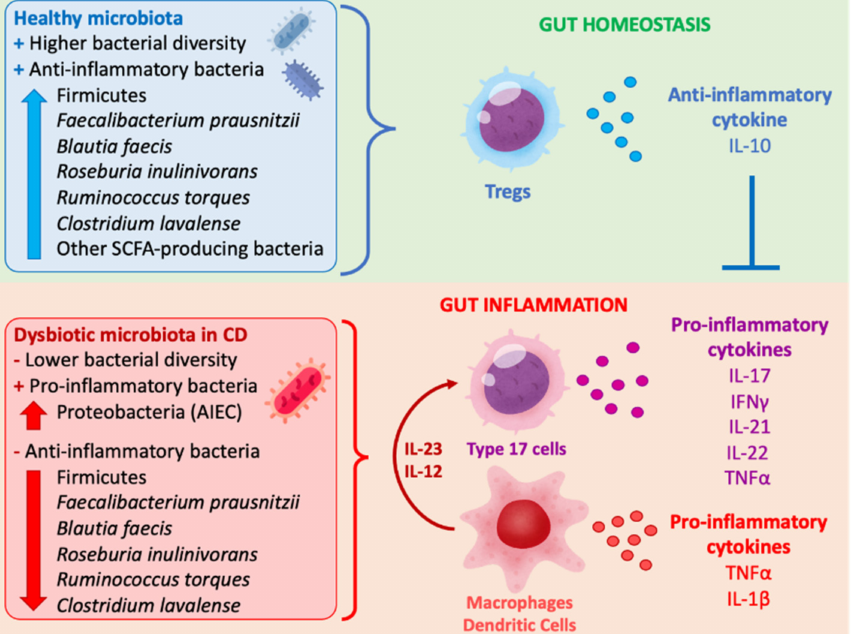
Figure 1. Overview of inflammatory mechanisms involved in CD progression related to gut